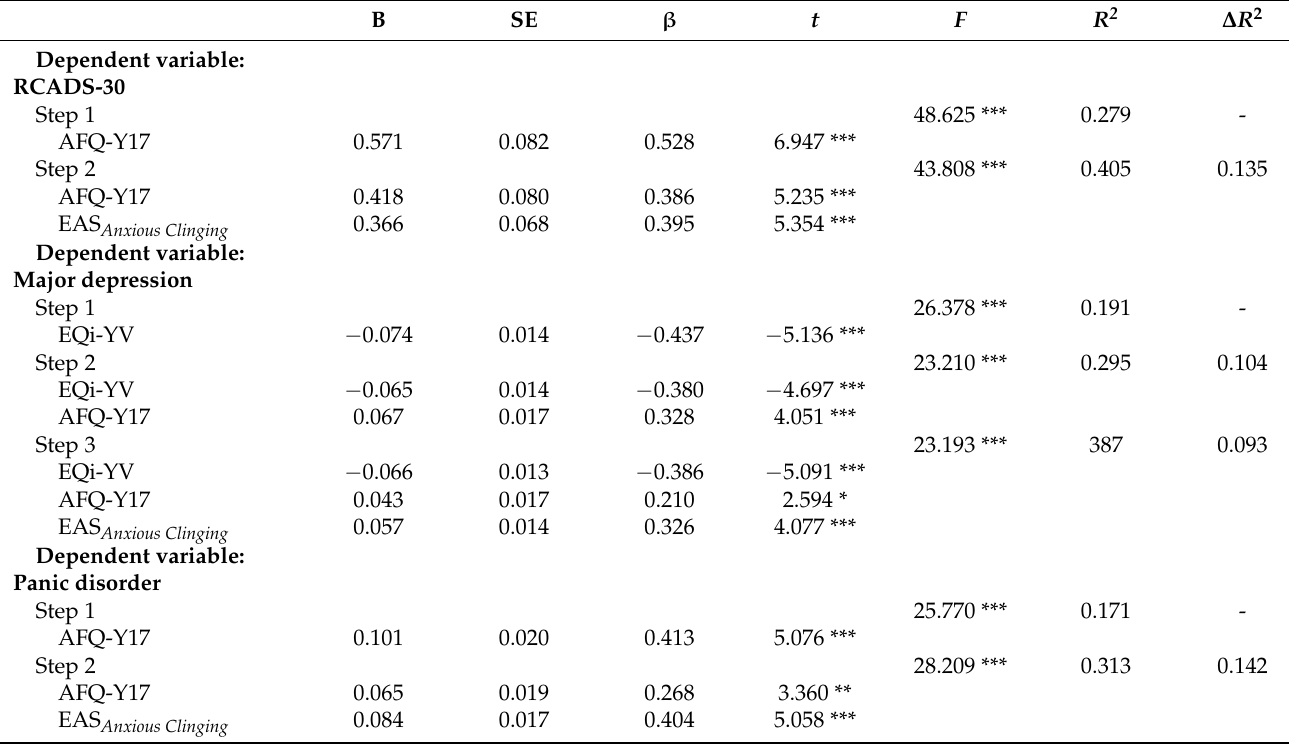
Table 6. Hierarchical regression predicting overall mental health symptoms (RCADS-30 total score), and major depression, panic disorder, social phobia, separation anxiety, generalized anxiety, and obsessive compulsive symptoms from Psychological Inflexibility (AFQ-Y17) and Anxious Clinging (EAS subscale). B